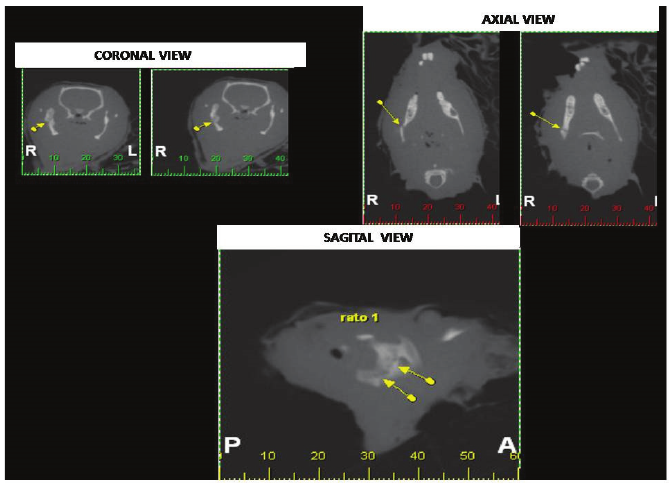
FIGURE 3 – CT scan of the control group at 21 days (the white arrows show the fracture